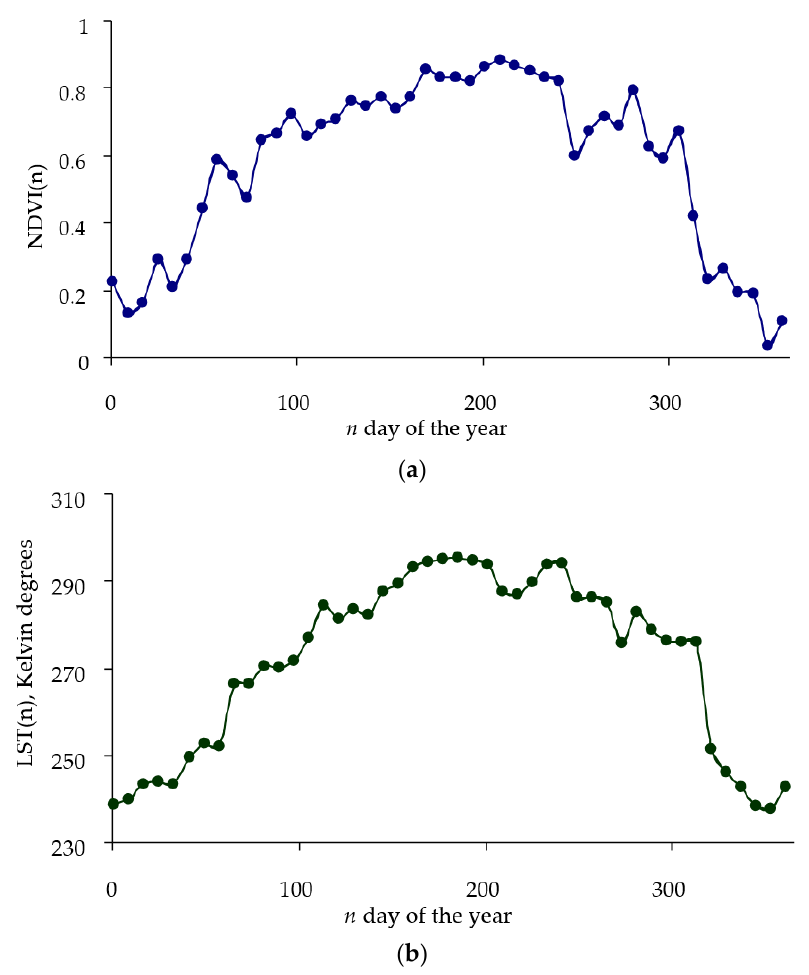
Figure 1. Typical annual dynamics of NDVI ( a ) and LST ( b ) (2010, site no. 12). Since the growth and condition of the crown of trees significantly depend on changes in ambient temperature, the analysis of the relationships between the NDVI and LST will make it possible to assess the adaptive resources of trees in the plantation. In this case, the change in the NDVI can be considered a function of changes in weather